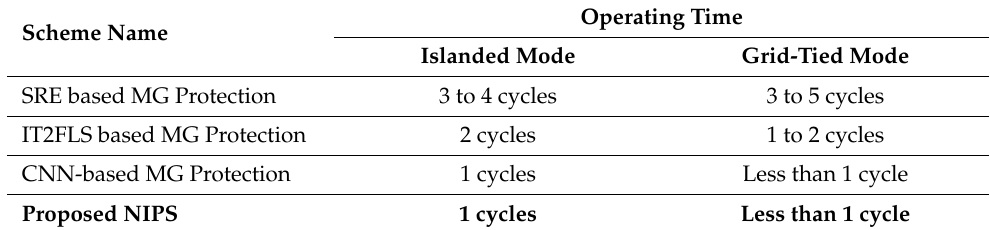
Table 7. Comparison of operating time of the proposed NIPS with existing